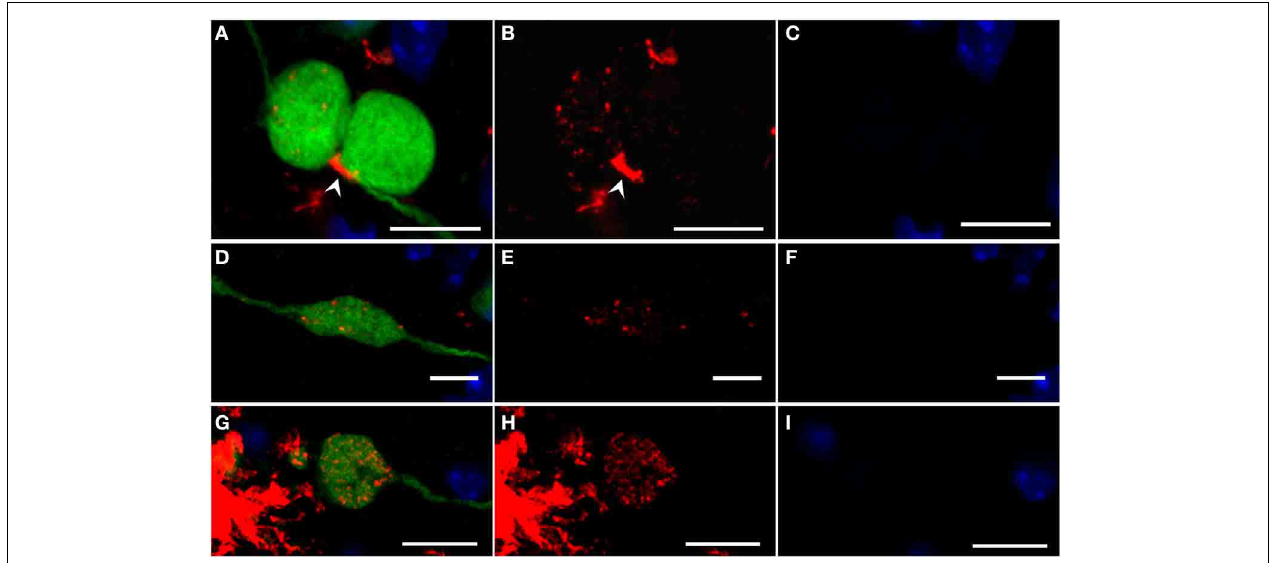
FIGURE 7 | Confocal images of fibrillar A β oligomers and A β fibrils (OC antibody, red) accumulating in large dystrophic fibers (YFP, green) of 6-month-old YFP/APP/PS1KI he mice with DAPI counterstaining confirming the lack of nuclei (blue). Merged images are shown (A,D,G) together with the isolated OC (B,E,H) , and DAPI staining (C,F,I) . Extracellular accumulation of A β (White arrowhead) could be detected near large